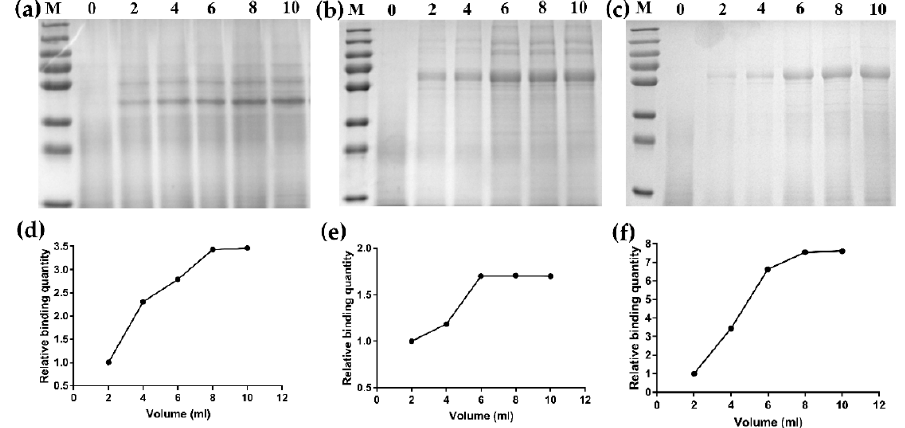
Figure 3. Detection of binding activity of the fusion proteins on GEM particles by SDS-PAGE. ( a – c ) The maximum binding capacity of each fusion proteins binding to the GEM particles when 0.5 U GEM particles was combined with 0, 2, 4, 6, 8 and 10 mL of each recombinant baculovirus culture supernatant. ( a ) RLP 2 -GEM; ( b ) RLP 3 -GEM; ( c ) RP 3 -GEM. ( d – f ) The relative binding quantity of binding fusion proteins on the GEM particles was detected densitometrically by analysis of scans of PAA gels with Gel Image System analysis software (Tanon, China). M: molecular weight marker; 0: GEM particles.